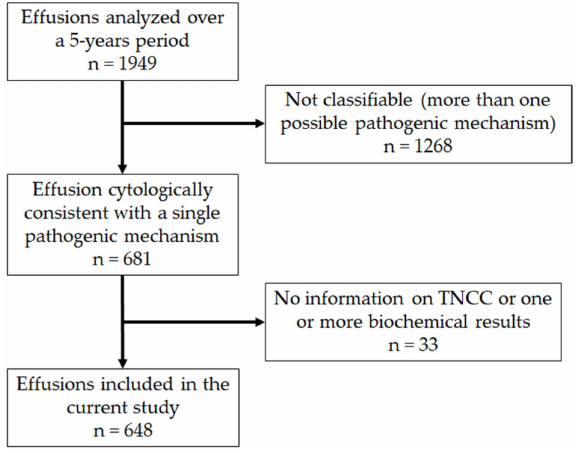
Figure 1. Flowchart summarizing the selection of the caseload according to the exclusion criteria.